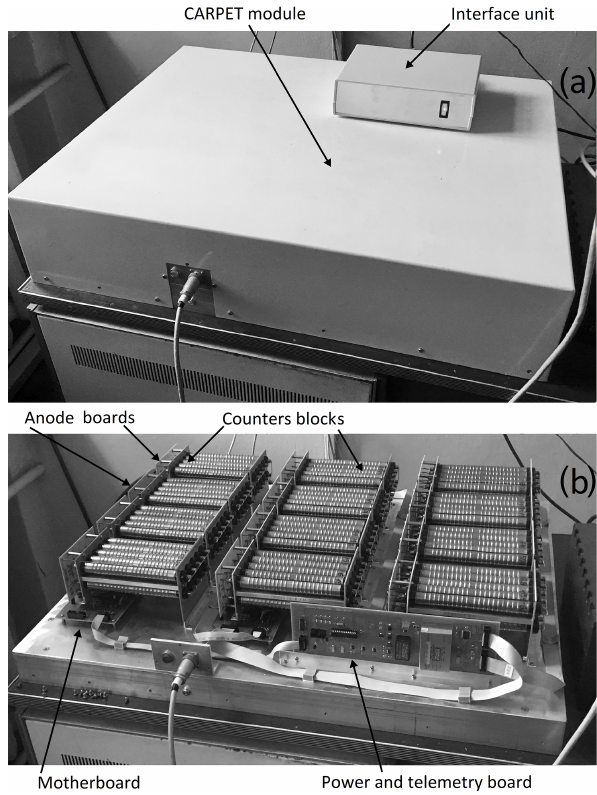
Figure 1. CARPET-MOSCOW installation and its components. (a) CARPET module with cover and (b) CARPET module without